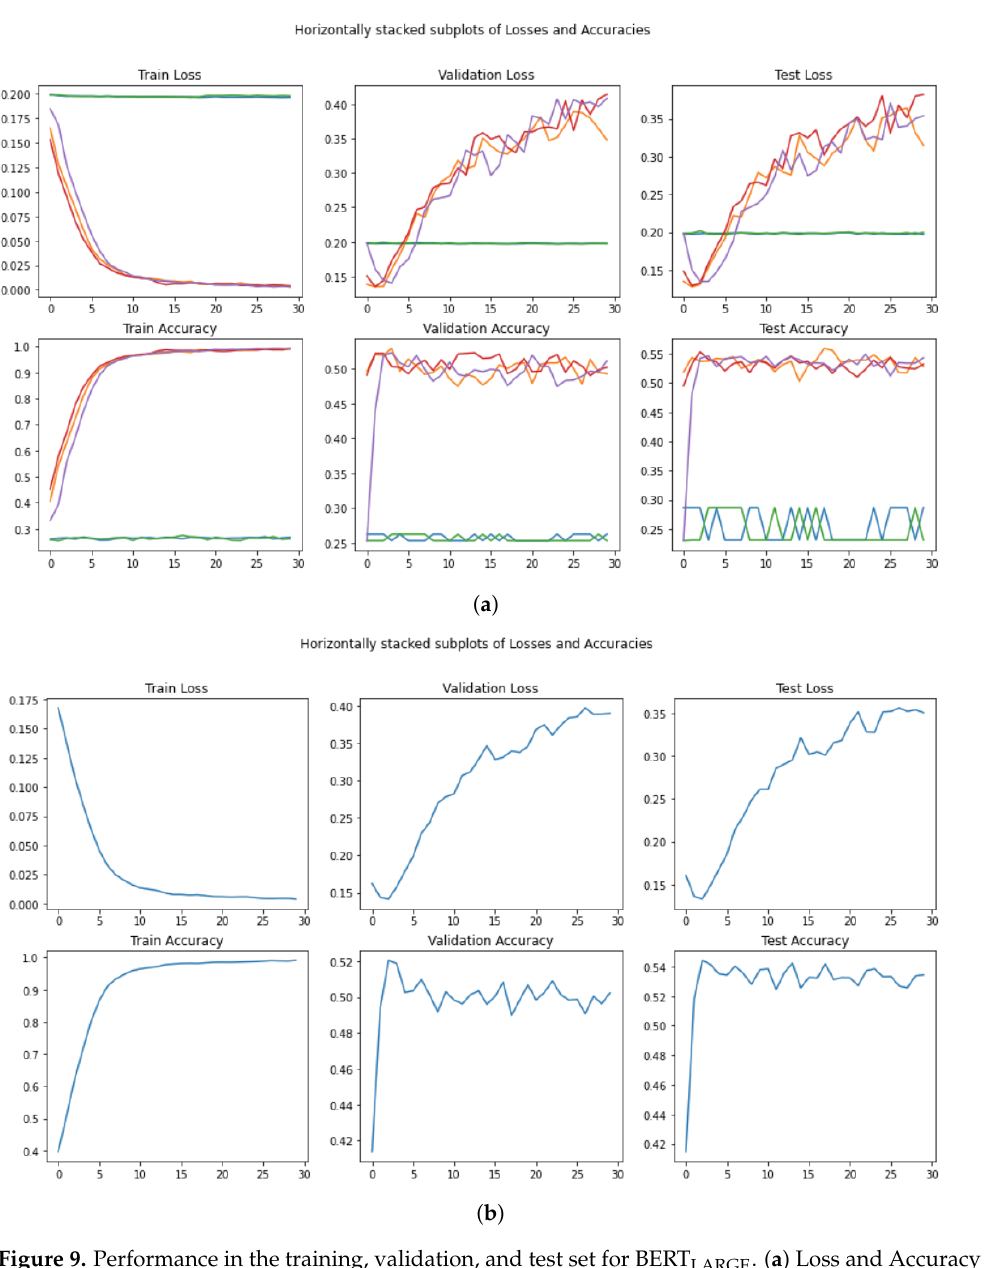
Figure 9. Performance in the training, validation, and test set for BERT LARGE . ( a ) Loss and Accuracy per run and per epoch. ( b ) Mean loss and mean Accuracy per epoch after non-converging runs are